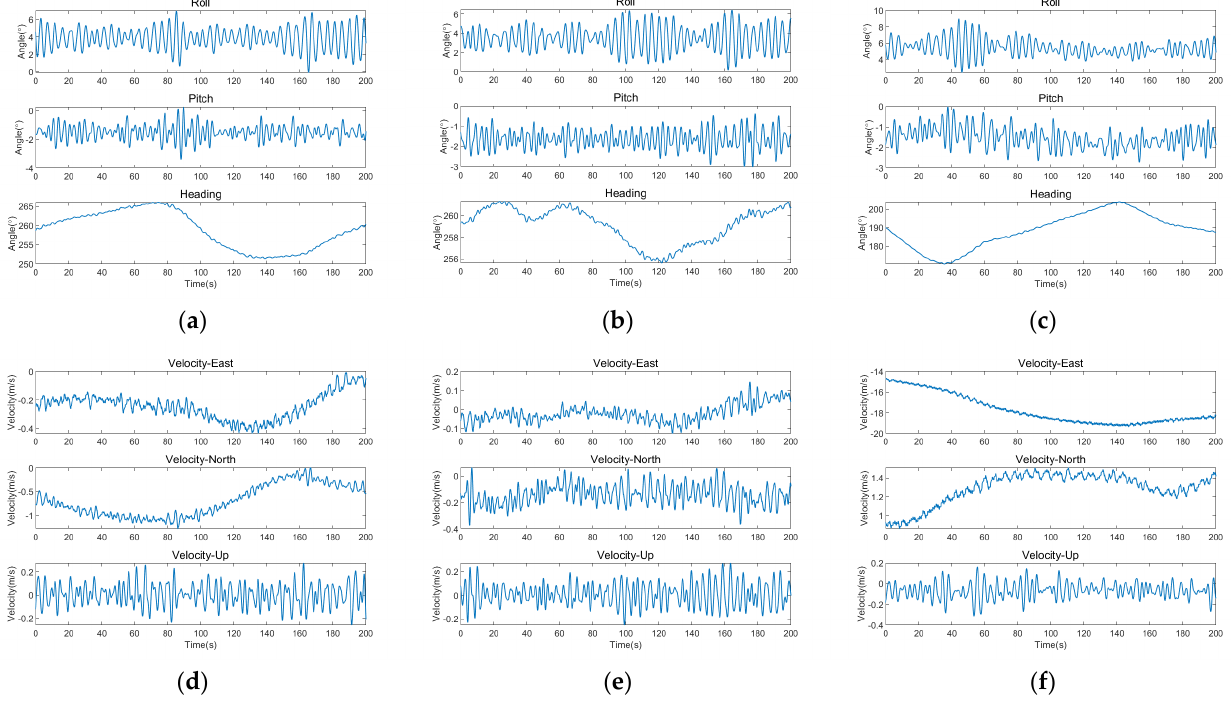
Figure 20. Part of the measured ship motion data during 200 s. ( a – c ) Attitude angles of the experimental ship in the unan- chored state, anchored state, and navigating state; ( d – f ) velocity of the experimental ship in the unanchored state, anchored state, and navigating state. Table 7. Ship attitude angles comparison in different states.